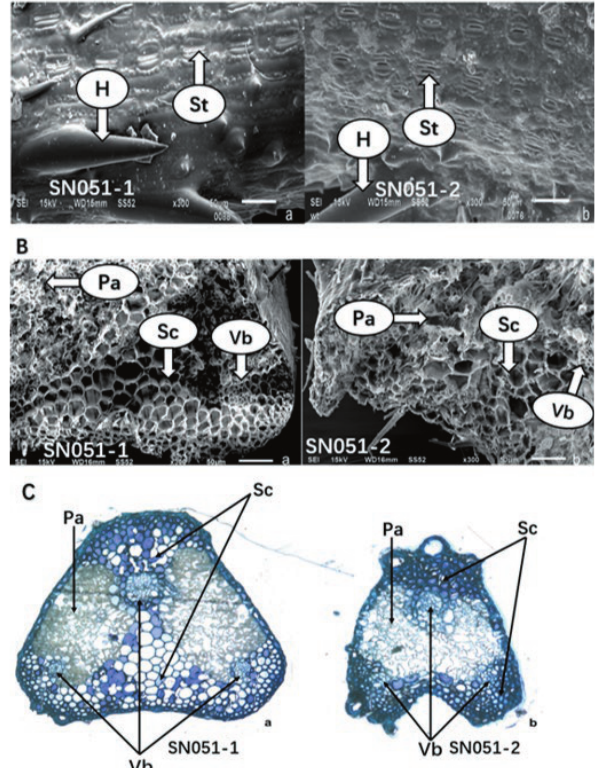
Figure 4. Awn external surface and cross-section of NILs. A. SEM images of the awn epidermis. St: stomata; H: hair. a. SEM images of the epidermis of SN051-1 awn, b. SEM images of the epidermis of